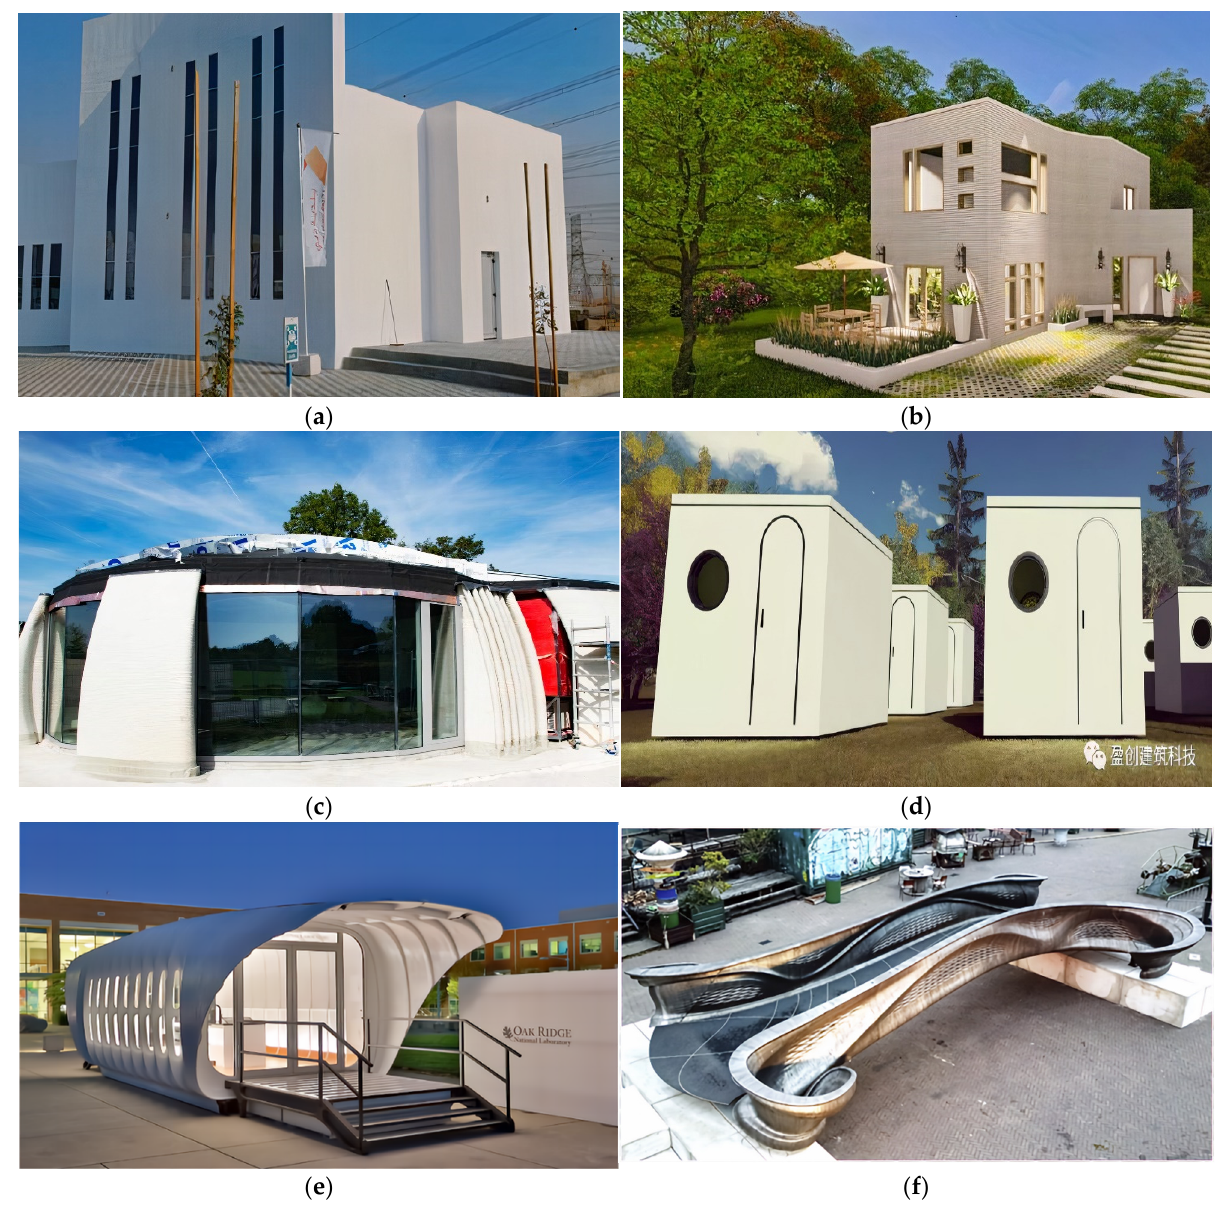
Figure 1. Recent AM Projects in the Construction Industry: ( a ) Apis Cor 3D printed building in